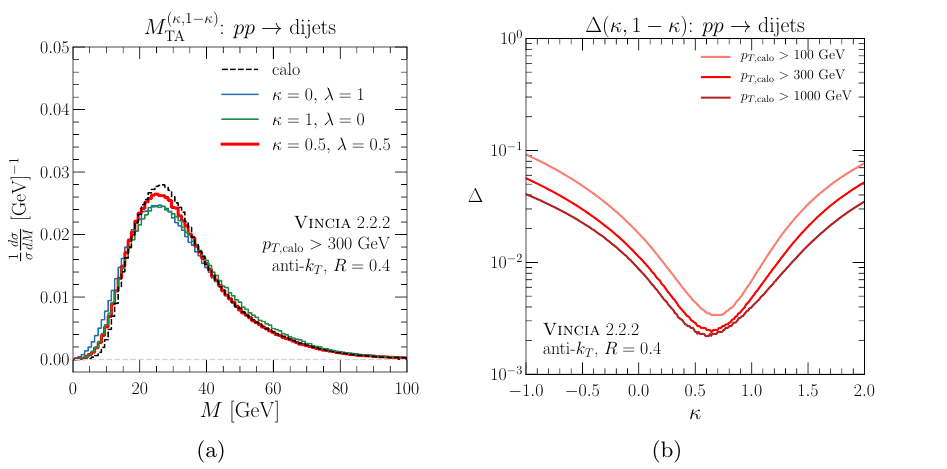
Figure 4 . Same as (cid:12)gure 2 but (a) with GTAM parameters ( (cid:20); (cid:21) ) = (b) (cid:1)( (cid:20); 1 (cid:20) ) as a function of (cid:20) (cid:0)